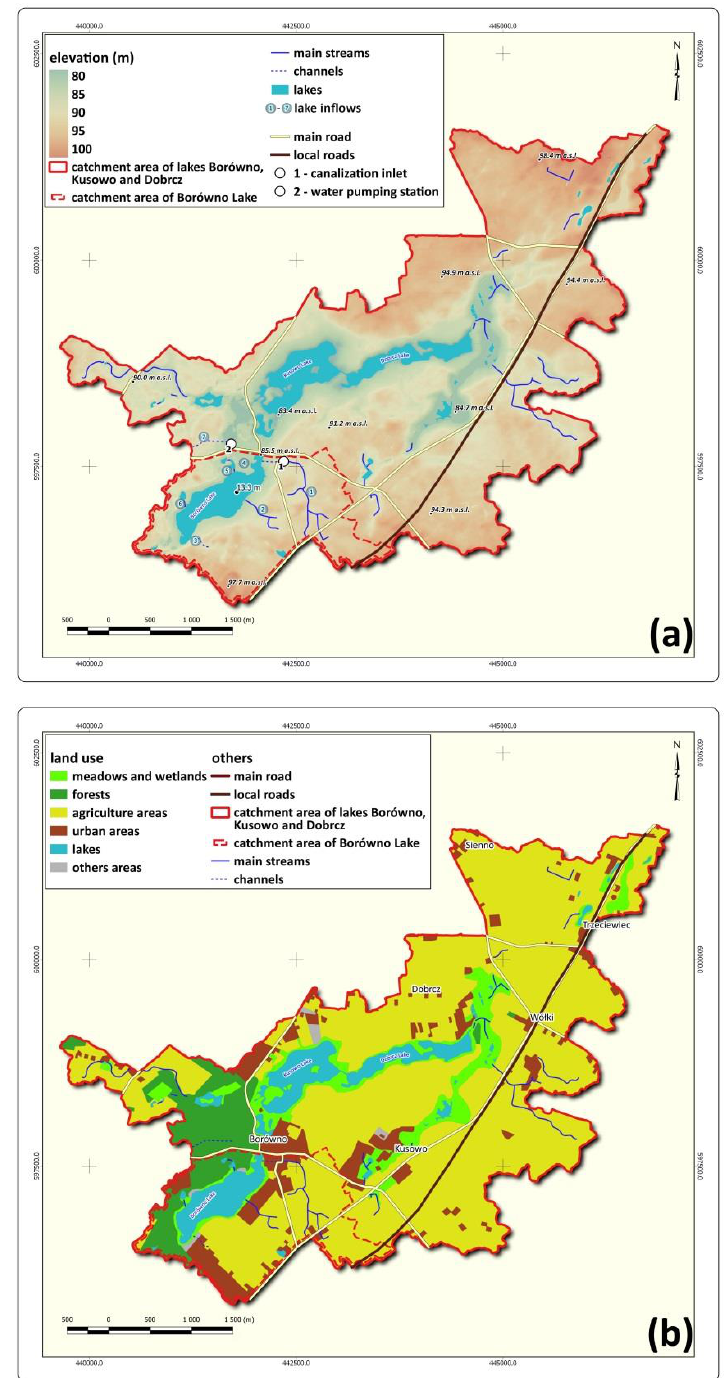
Figure 2. Total and direct catchment of Lake Borówno: ( a ) against the background of the numerical terrain model (prepared based on [62,63]), ( b ) against the background of land use (prepared based on [63,64]).